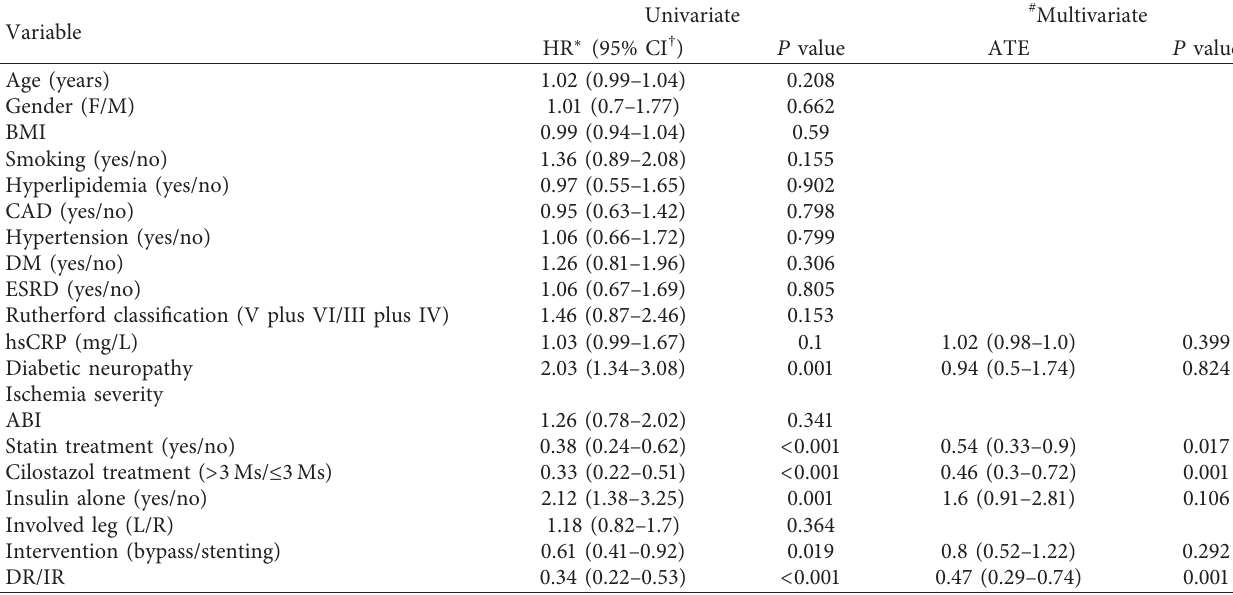
Table 4: Cox regression analysis of primary patency.